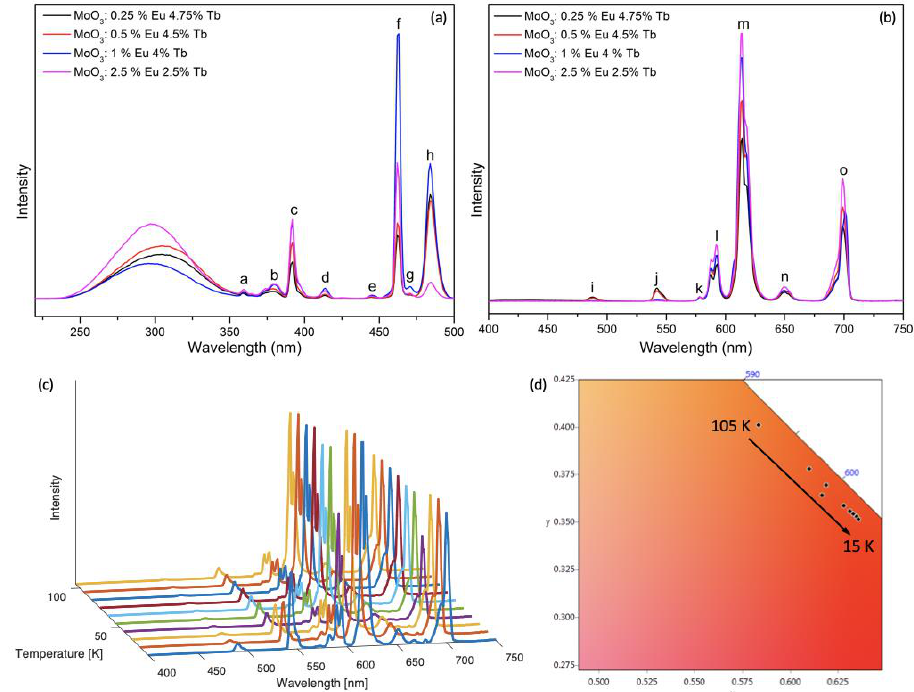
Figure 4. ( a ) Excitation and ( b ) emission spectra of Eu 3 + , Tb 3 + co-doped α -MoO 3 at di ff erent Eu 3 + / Tb 3 + percentages, recorded at room temperature ( λ ex = 305 nm; λ em = 614 nm); ( c ) the temperature